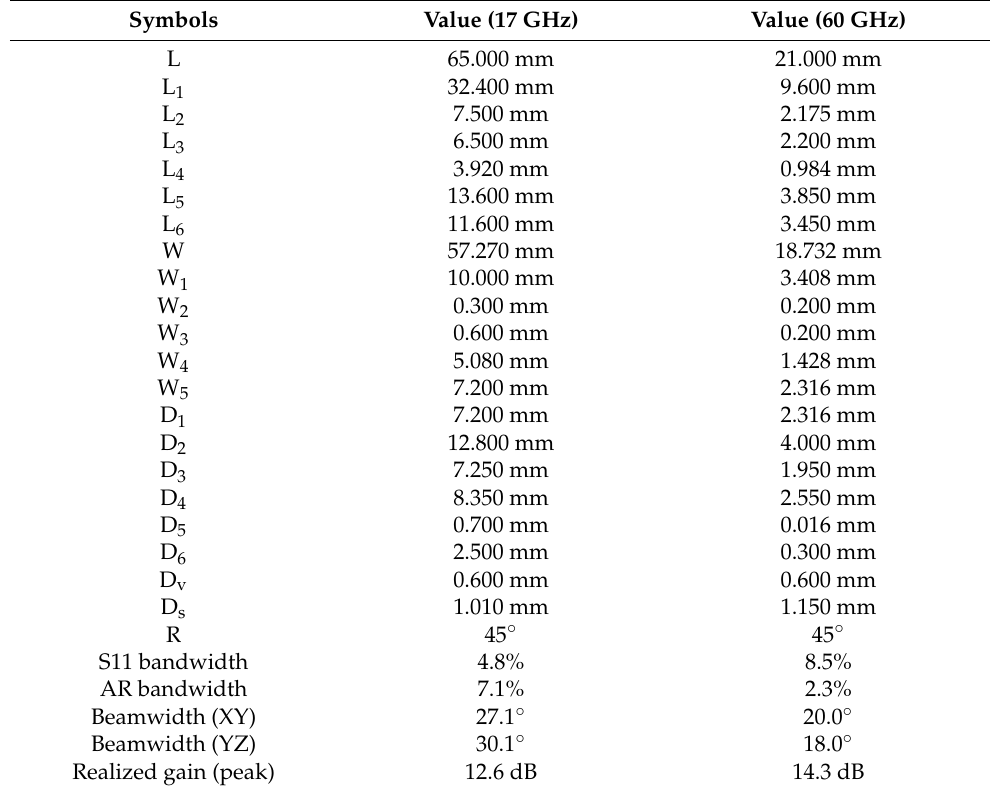
Table 2. Comparison of dimensions and parameters of the arrays for the center frequencies of 17 and 60